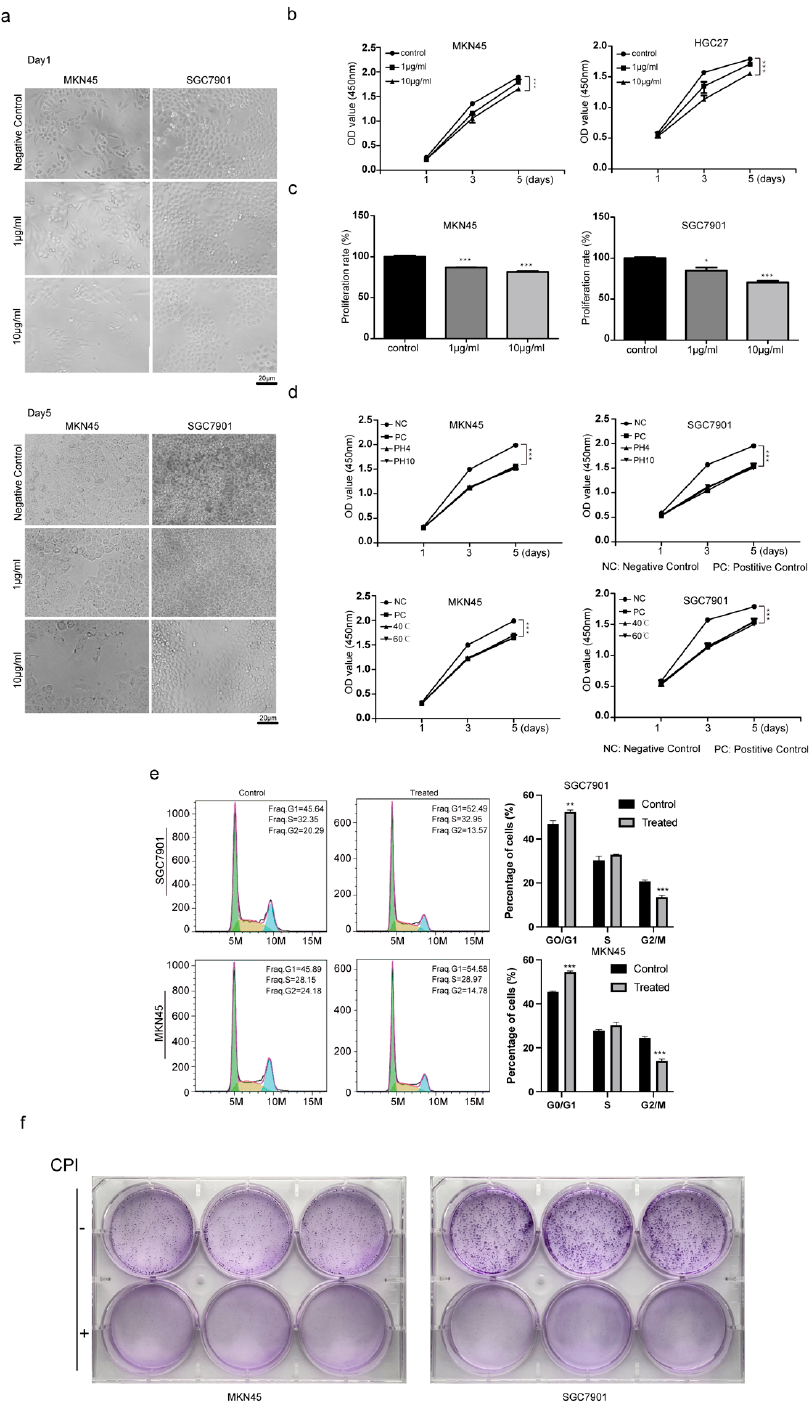
Figure 3. The recombinant protein of the silkworm carboxypeptidase inhibitor significantly inhibited the proliferation of gastric cancer cells. ( a ) Gastric cancer cells treated with silkworm carboxypeptidase inhibitor. ( b ) Proliferation of gastric cancer cells was measured by the CCK-8 method. ( c ) Inhibition rate of silkworm carboxypeptidase inhibitors on gastric cancer cells. ( d ) Potent Bombyx mori carboxypeptidase inhibitor inhibitory activity on gastric cancer cells under different conditions. ( e ) Cell cycle analyses after Bombyx mori carboxypeptidase inhibitor treatment. ( f ) Bombyx mori carboxypeptidase inhibitor inhibits colony formation in gastric cancer cells. The differences between the experimental and the control groups were analyzed by the Student’s t test, * p < 0.05, ** p < 0.01, *** p <